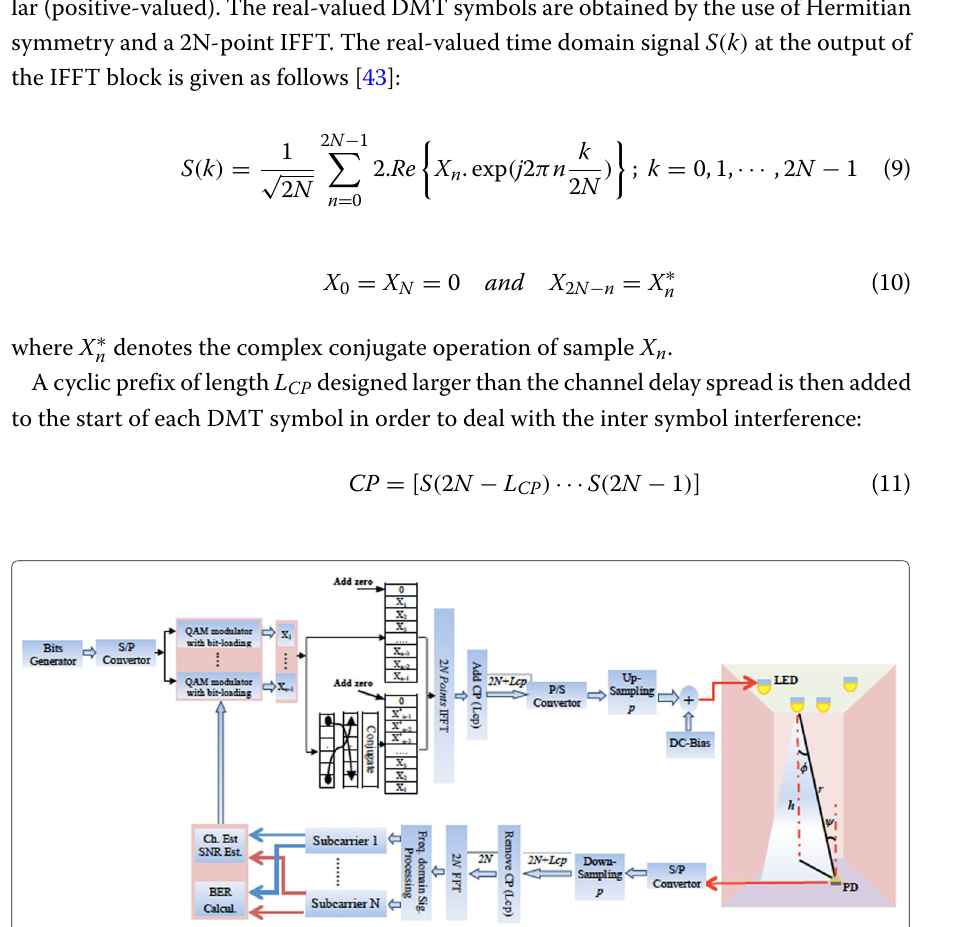
Fig. 3 Schematic diagram of an indoor VLC system using DMT